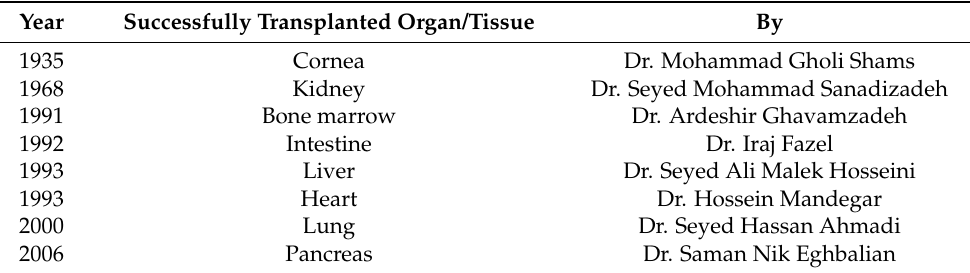
Table 1. The process of successful organ transplantations in